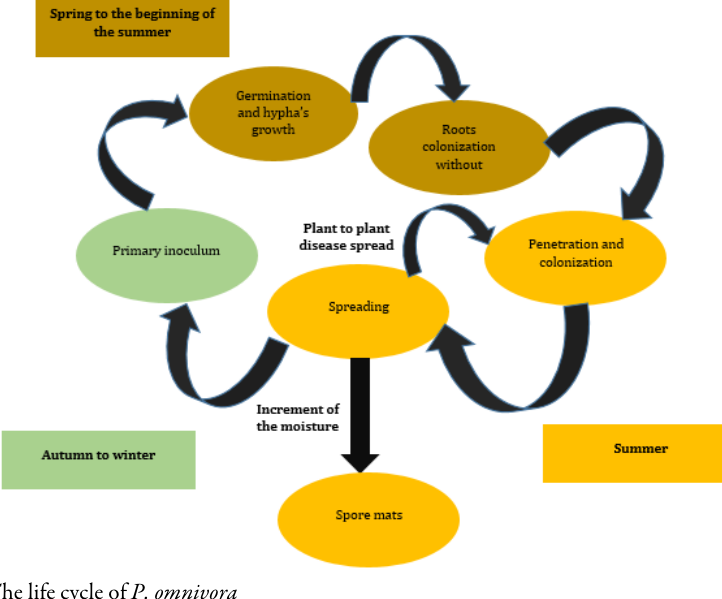
Figure 3. The life cycle of P. omnivora